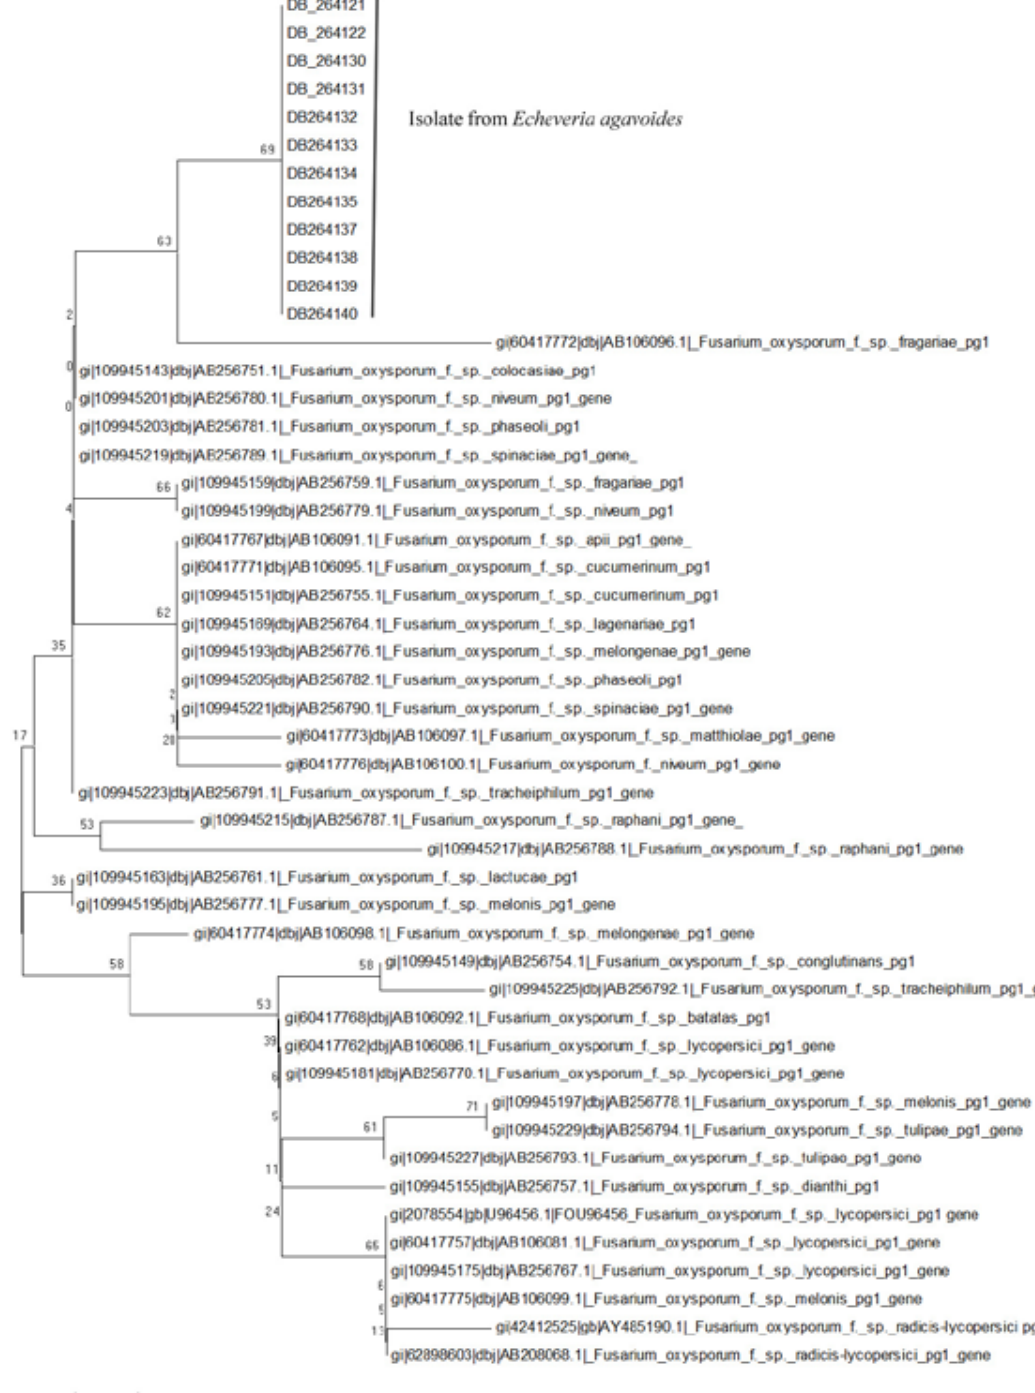
Figure 2. Phylogenetic tree based on Pg1 gene sequences, built by Mega5 software with the Neighbour joining method with 1,000 bootstrapping